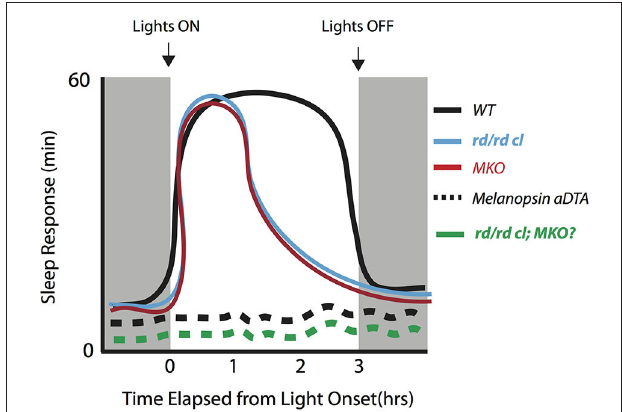
FIGURE 1 | Initiation and maintenance of sleep across different genotypes early in the dark period to a bright saturating light pulse . The induction of sleep can be maintained for at least 3-h early in the dark period in WT mice (black line). In the absence of melanopsin (MKO) or rod-cone photoreception ( rd/rd cl ), there is an initial increase in sleep but lack of maintenance for the remainder of the light pulse in both genotypes (Altimus et al., 2008; Muindi et al., 2013; red and blue lines). When the melanopsin expressing RGCs are selectively ablated by the expression via the expression diphtheria toxin-A (aDTA) in the melanopsin locus (Altimus et al., 2008) the light-induced sleep response is completely abolished (black dotted line). This suggests that these cells serve as an exclusive pathway for mediating the acute effects of light. The sleep response in the triple knockout ( rd/rd cl/ MKO) is currently not known, but is likely to mimic the results from the melanopsin aDTA mice (green dotted